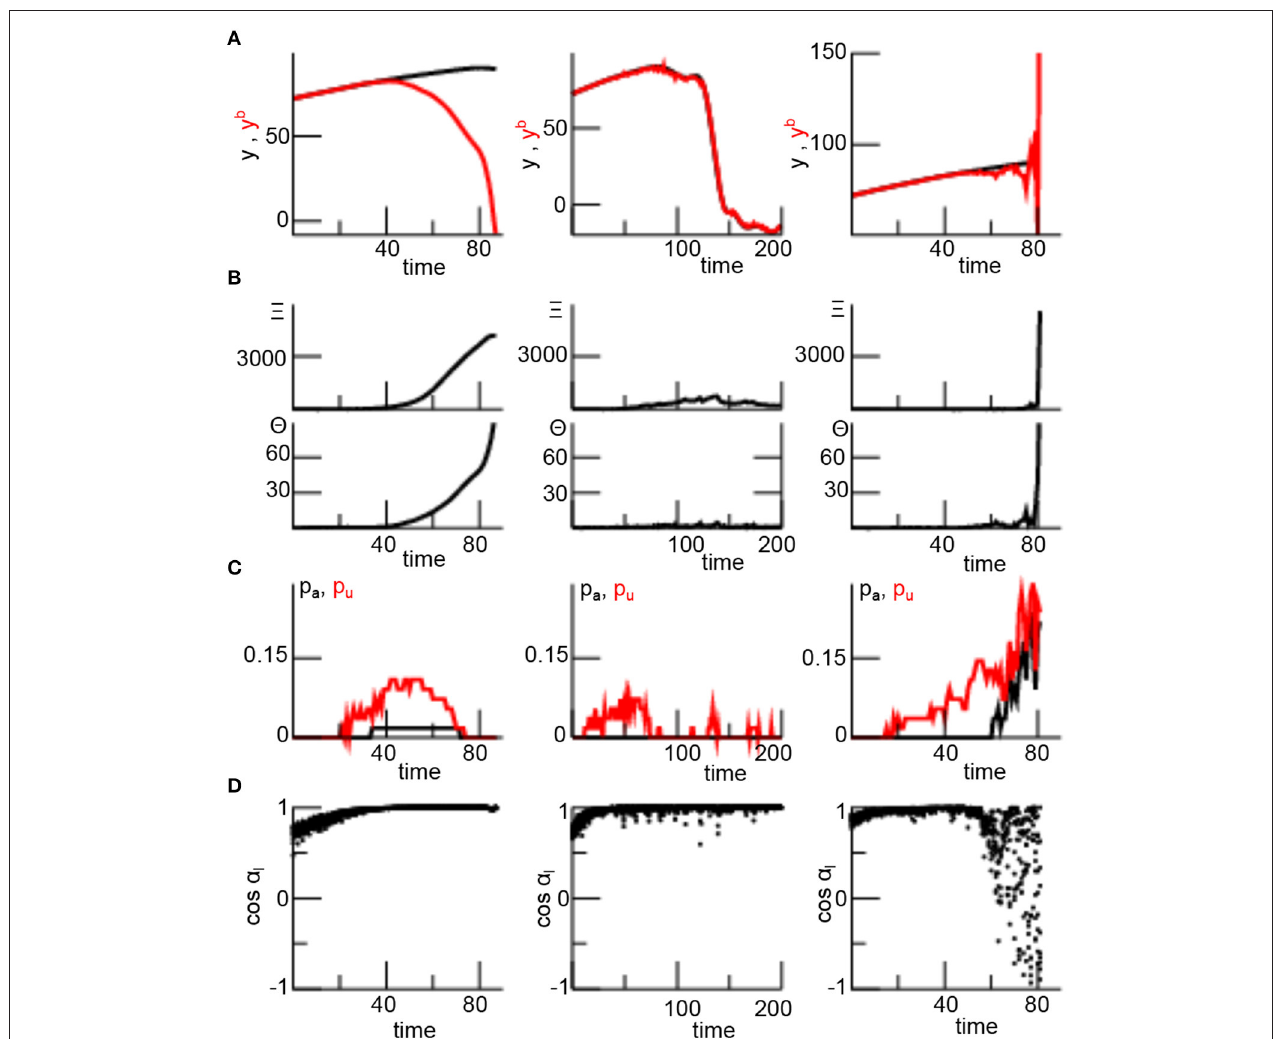
FIGURE 7 | Various measures reflecting stability of the LETKF dependent on the localization radius r l in single trials. (A) observation y o (black) and its model x b (red). (B) Statistical quantities 4 n (top) and 2 n (bottom), for definition see section 2.8. (C) The probability of ensemble member alignment according to equivalent H ¯ Equation (26) for aligned (black) and anti-aligned (red) members. (D) Statistical estimate of alignment between ensemble members and x a Equation (27). The different localization radii are r l 1 (left panel), r l 6 (center panel), and r l 20 (right panel) with the sensitivity function width r H = = =